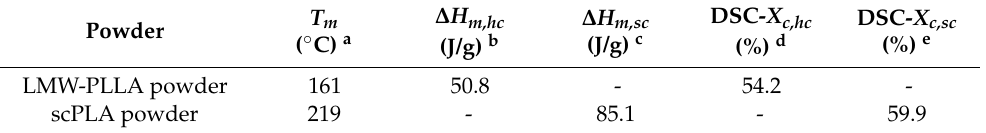
Figure 2. DSC heating curves of ( a ) LMW-PLLA and ( b ) scPLA powders. Table 2. DSC results of LMW-PLLA and scPLA powders obtained from Figure 2.